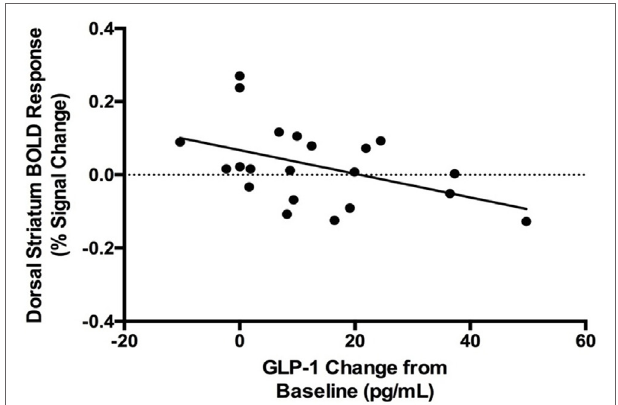
FigUre 4 | Negative correlation between blood oxygen level dependent (BOLD) response to food cues in the dorsal striatum and systemic GLP-1 response to oral glucose ( r s = − 0.46, p =